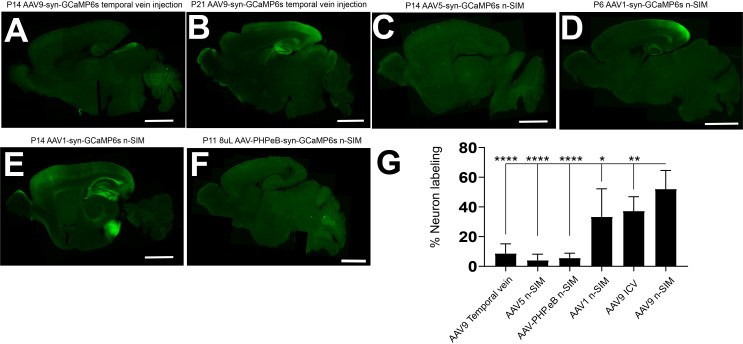
Comparison of AAV9 n-SIM to other methods.(A,B) Sagittal sections of P14 and P21 mouse brains with bilateral temporal vein injections of AAV9-syn-GCaMP6s at P1. (A) Exposure time = 2000 ms. Minimum-Maximum display range in ImageJ (Unsigned 16-bit range)=73–2500. (B) Exposure time = 1000 ms. Minimum-Maximum display range in ImageJ (Unsigned 16-bit range)=73–2500. (C) Sagittal sections of P14 mouse brains with AAV5 n-SIM at P1. Exposure time = 1000 ms. Minimum-Maximum display range in ImageJ (Unsigned 16-bit range)=73–2500. (D,E) Sagittal sections of P6 and P14 mouse brains labeled with GCaMP6s using AAV1 n-SIM at P1. Exposure time = 2000 ms. Minimum-Maximum display range in ImageJ (Unsigned 16-bit range)=73–2500. (F) Sagittal section of P11 brain injected with 8 μL of AAV-PHP.eB-syn-GCaMP6s (1 × 1013 vg/mL). Exposure time: 1000 ms. Minimum-Maximum display range in ImageJ (Unsigned 16-bit range)=73–500. (G) Quantification of cortical neuron labeling from injected mouse pups ranging from P6-P21 using AAV9 temporal vein injections at P1, AAV5 n-SIM at P1, AAV1 n-SIM at P1, AAV-PHP.eB n-SIM at P1, AAV9 ICV at P0-P1, and AAV9 n-SIM at P1. Note comparison to AAV9 n-SIM at P1 (also refer to Figure 1H). Scale bars are 2 mm.